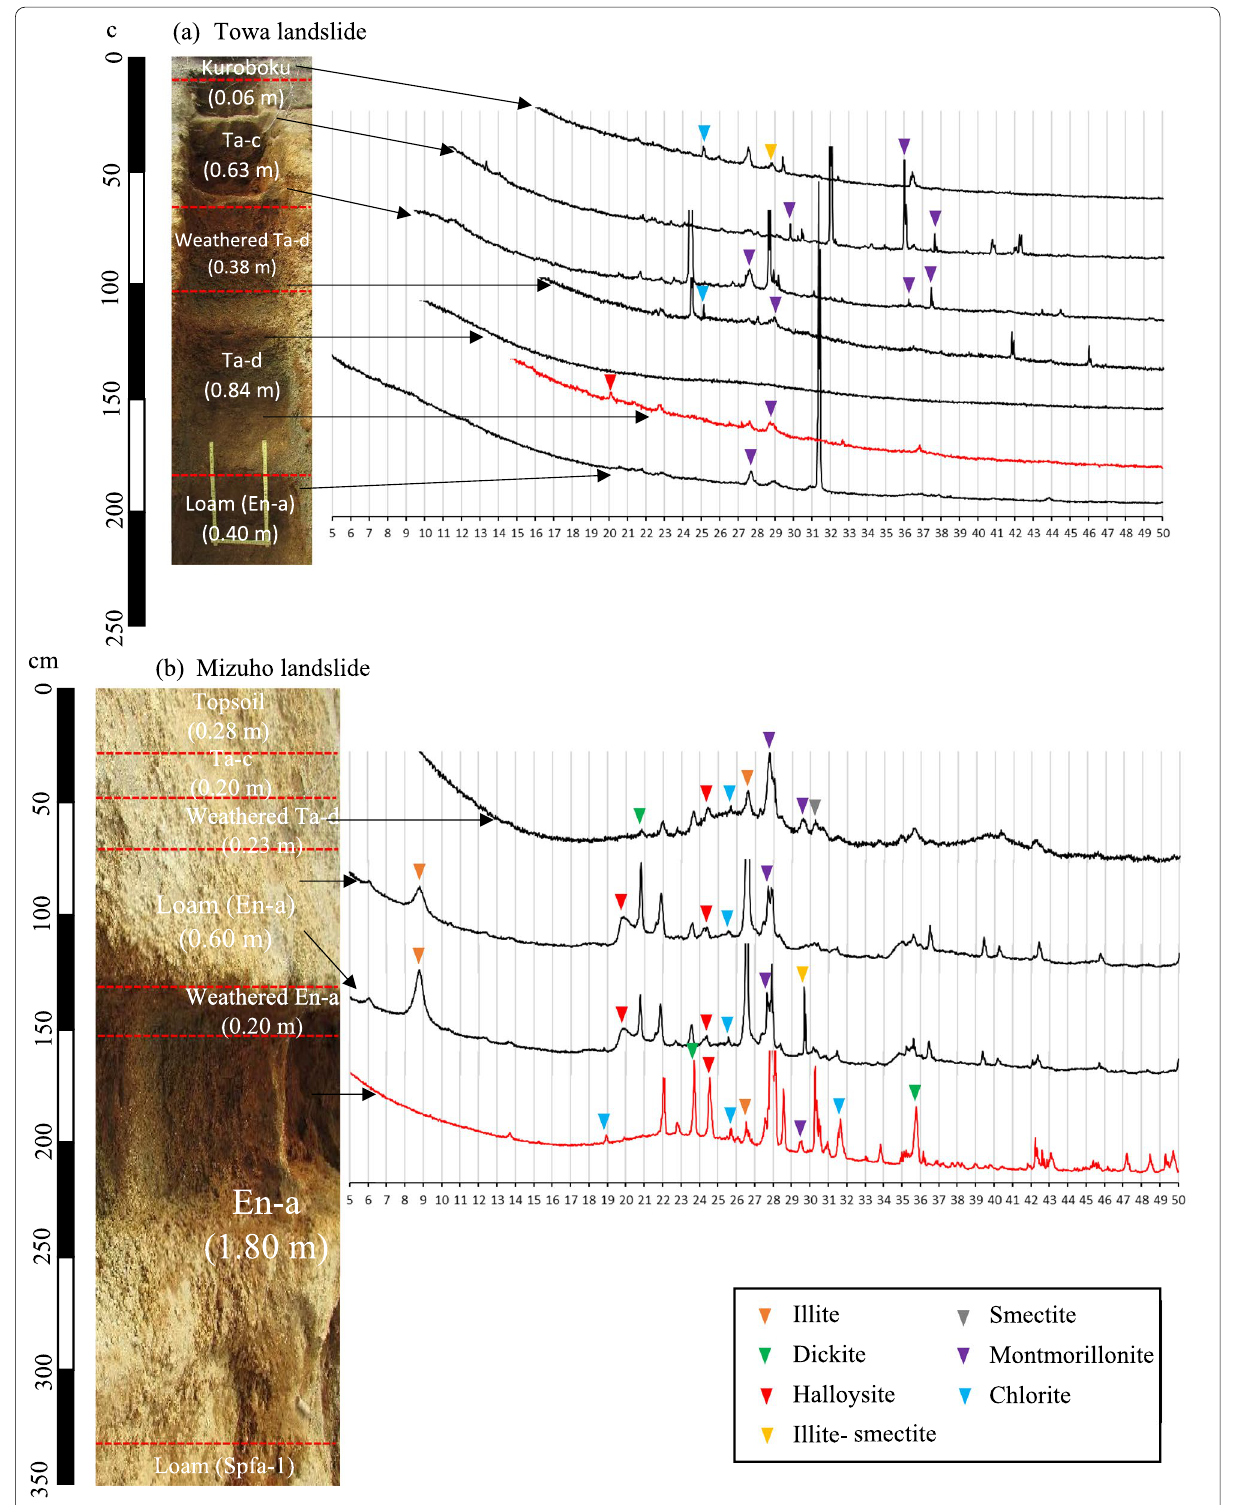
Fig. 9 Clay minerals on tephra materials from Towa and Mizuho